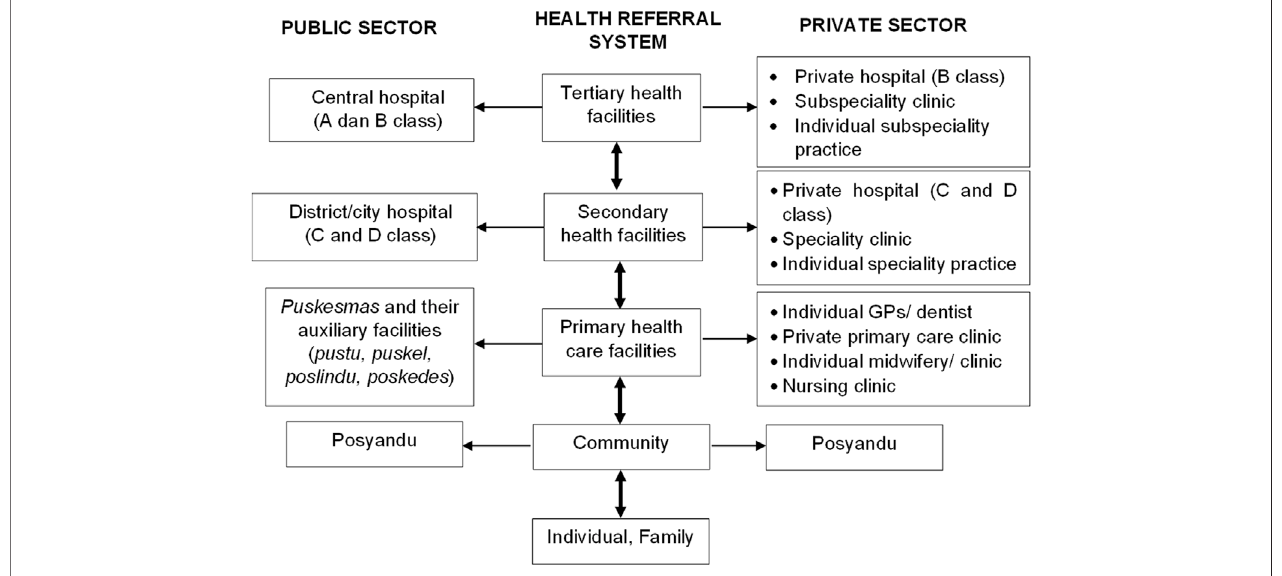
FIGURE1| Indonesiahealthreferralsystem.Volunteers(cadres)operateposyanduforvulnerablepopulationgroupsatthecommunitylevelintheirareasupervised by puskesmas .